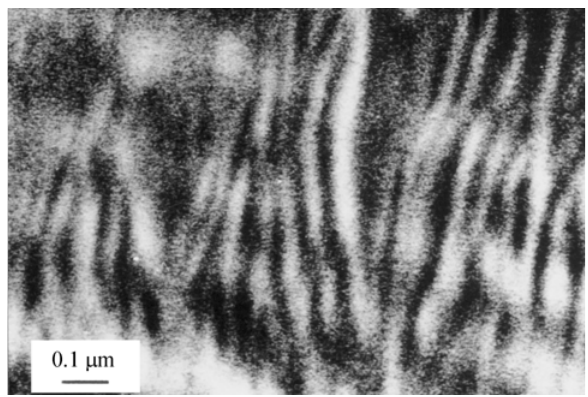
Figure 10. Higher magnification micrograph of initial transcrystalline HDPE lamellae from region S 2 (see Figs. 7 and 9(b) for sample location).